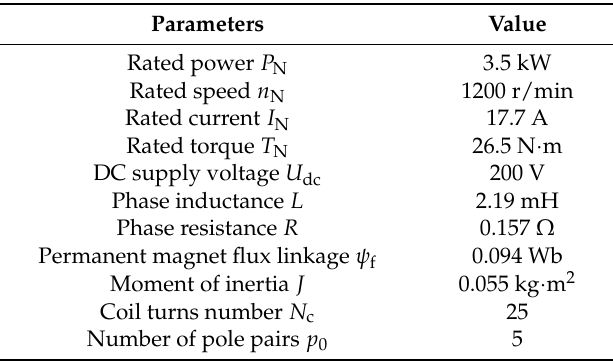
Table 1. Parameters of the